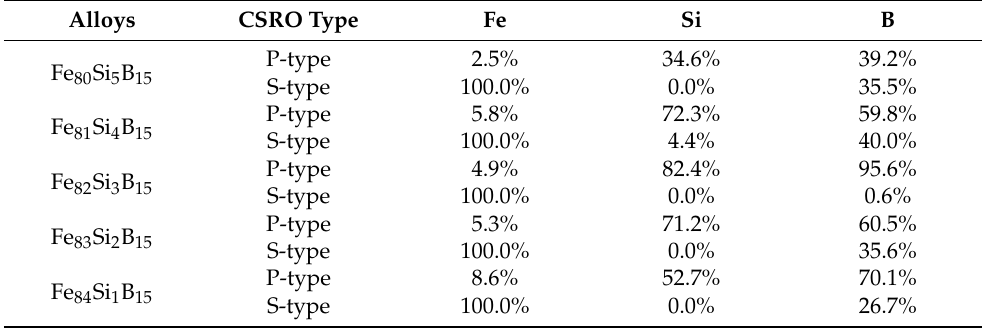
Figure 4. Fractions of the Fe- and M-centered CSROs in the Fe 80+x Si 5 − x B 15 ( x = 0–4) alloys at 300 K: ( a ) Fe-centered; ( b ) Si-centered; and ( c ) B-centered. Table 5. Type and fraction of atom-centered CSROs in the Fe 80+x Si 5 − x B 15 ( x = 0–4)